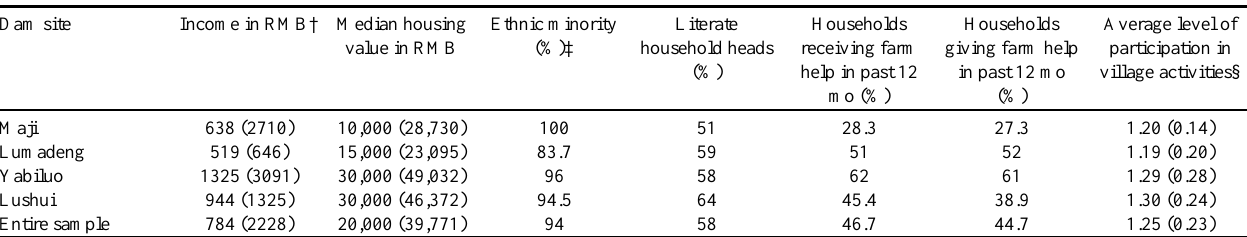
Table 6. Projected socioeconomic vulnerabilities of the Nu River, China, to hydropower development. Standard deviations in